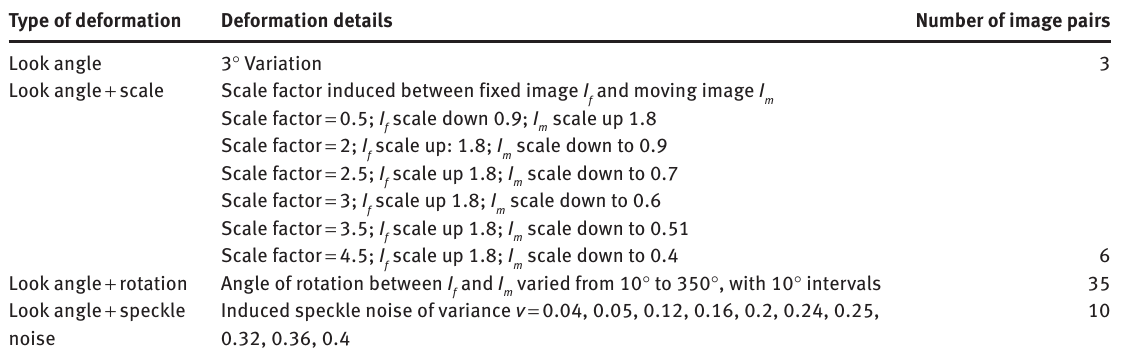
Table 1: Synthesized SAR Image Dataset with Induced Deformation